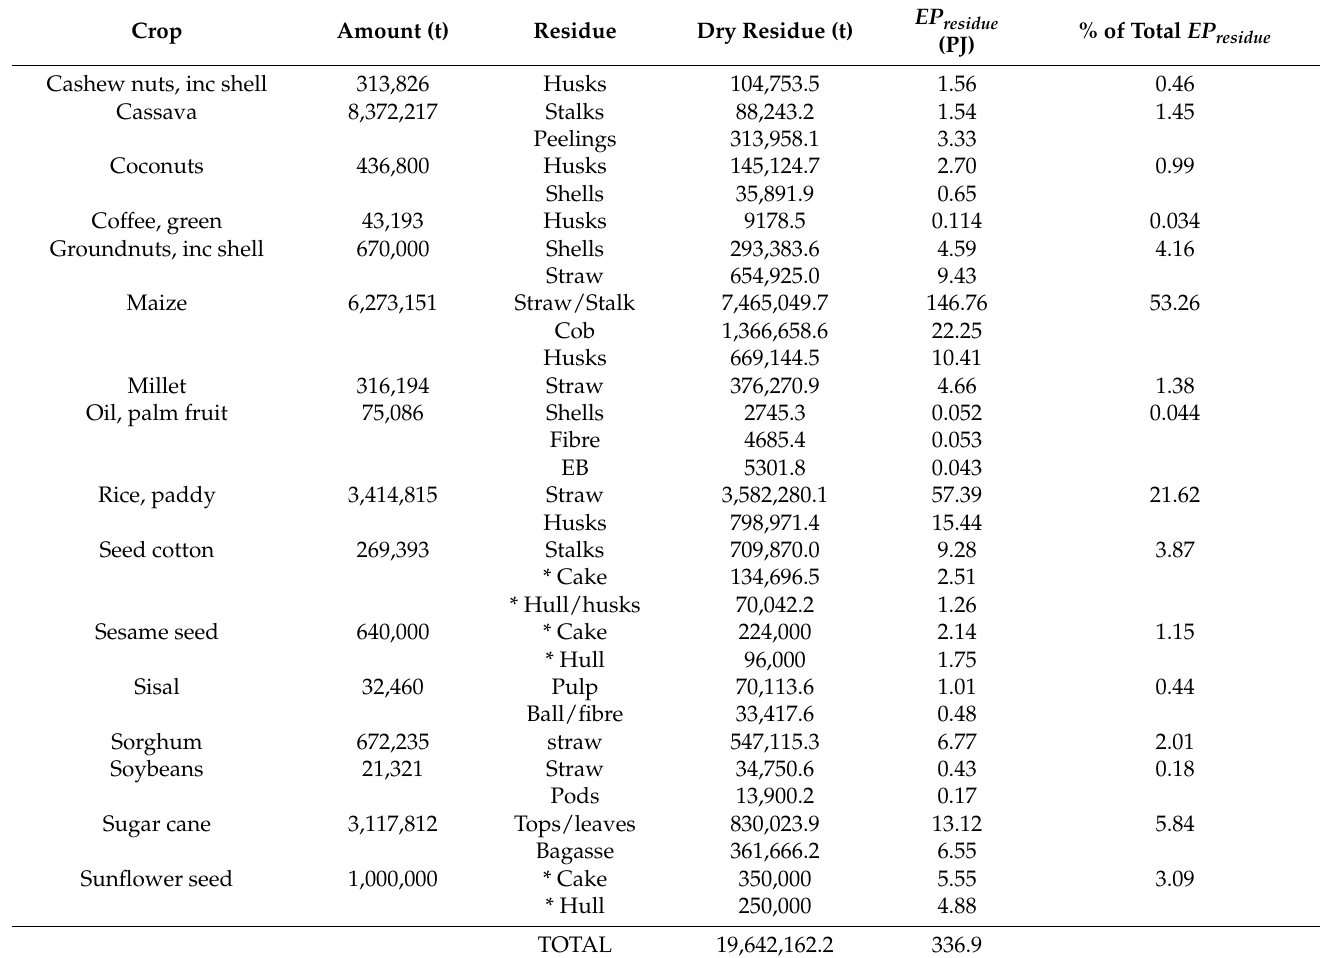
Table 5. The energy potential arising from waste agricultural residues.